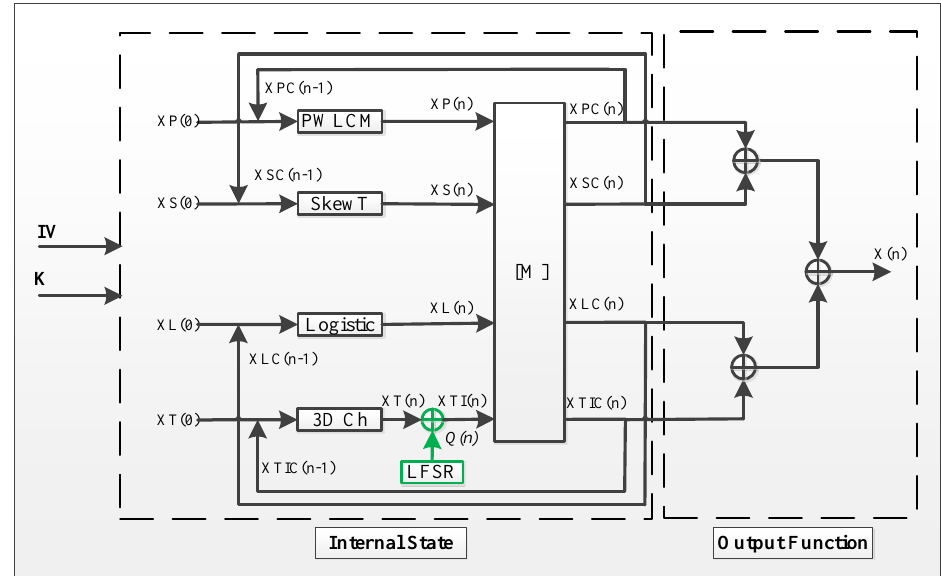
Figure 8. LSPT-PRNG design architecture